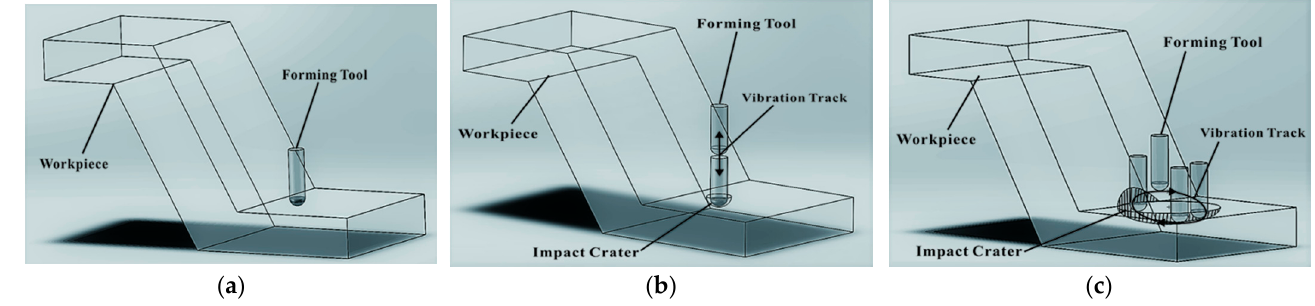
Figure 2. Ultrasonic vibration mode of progressive forming. ( a ) Without ultrasonic vibration; ( b ) vertical ultrasonic vibration; ( c ) 2D ultrasonic vibration.